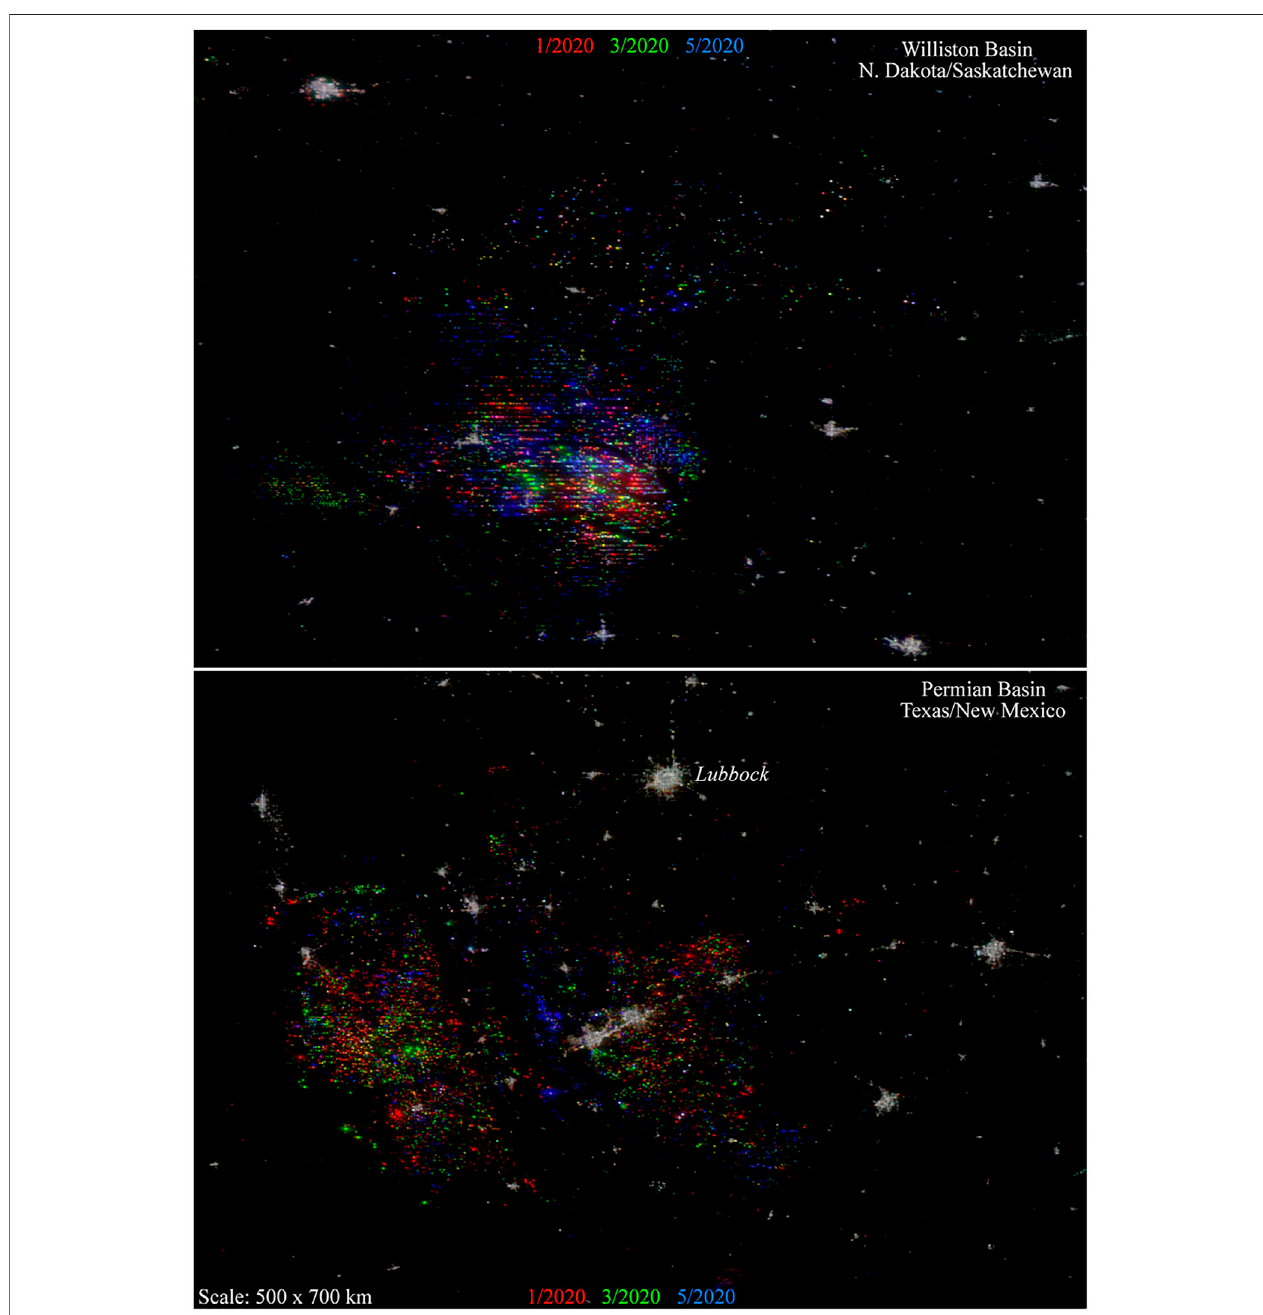
FIGURE 10 | Intermittent lights and gas fl ares from densely spaced hydrofracture wells in North America. Tri-temporal composites of monthly mean radiance for early 2020 shows small urban lights unchanging (shades of gray). Color implies change. Warmer colors imply dimming between January and May 2020.